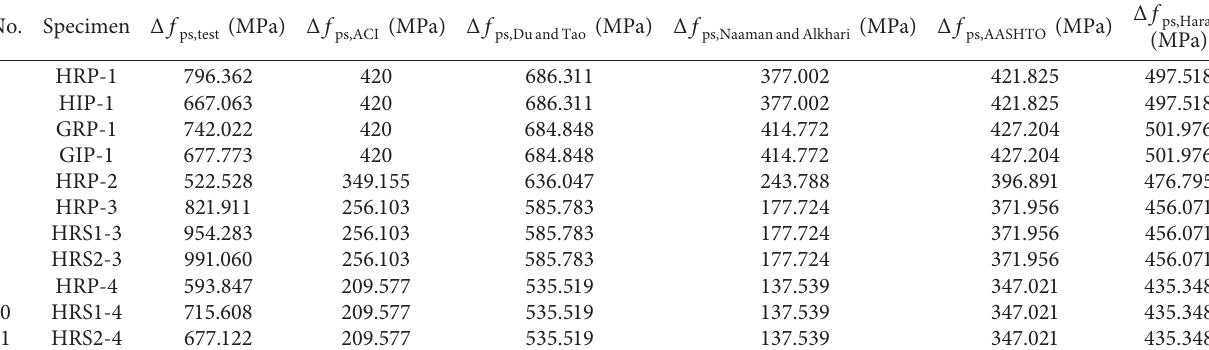
Figure 12: Comparison of predictions of increase of stress in strands. Table 4: Comparison of stress increase in unbonded tendons at ultimate.